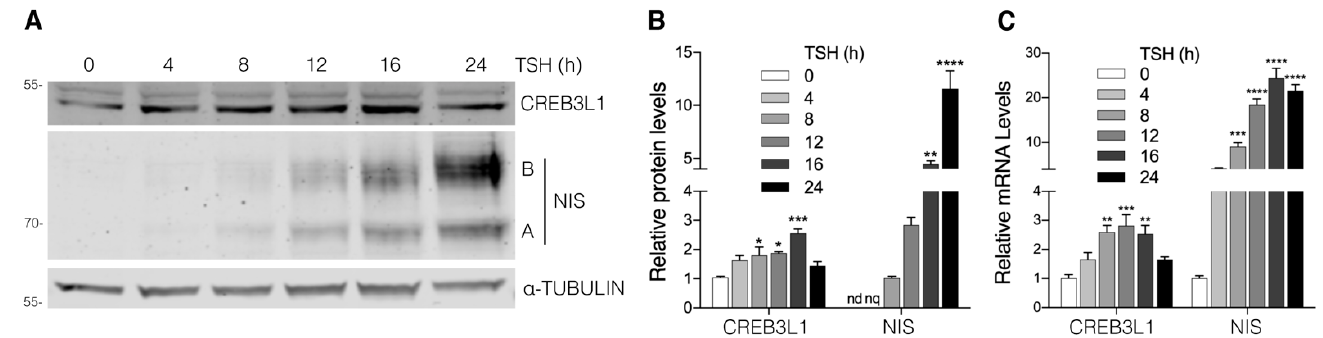
Figure 1. Kinetics of CREB3L1 and NIS expression in response to TSH stimulation. ( A ) Representative Western blot with antibodies against CREB3L1 and NIS of lysates from the FRTL-5 cells incubated under the starvation condition for 72 h (TSH 0 h) and then stimulated with TSH (1.5 mIU/mL) for the indicated times. Labels on the right side of the blot indicate the relative electrophoretic mobilities of the corresponding NIS polypeptides depending on their glycosylation status: immaturely glycosylated ( ∼ 60 kDa, band A) and fully glycosylated (~100 kDa, band B). ( B ) Densitometric quantification of the proteins shown in A. The intensity of each band relative to α -tubulin (loading control) was measured, and the fold change was calculated as the ratio between the induced and the uninduced situations. The relative density was set to 1 at 0 h for CREB3L1 and to 8 h for NIS; nd, not detectable; nq, not quantified. The results are expressed as the means ± SEM of at least three independent experiments (* p < 0.05; ** p < 0.01; *** p < 0.001; **** p < 0.0001). ( C ) Quantification of mRNA levels by qPCR with total RNA obtained from the FRTL-5 cells stimulated with TSH (1.5 mIU/mL) for the indicated times. The results were normalized to β -actin and expressed according to the 2 −∆∆ Ct method relative to the expression level at 0 h (set as 1). The results are expressed as the means ± SEM of three independent experiments performed in triplicate (** p < 0.01; *** p < 0.001; **** p < 0.0001).